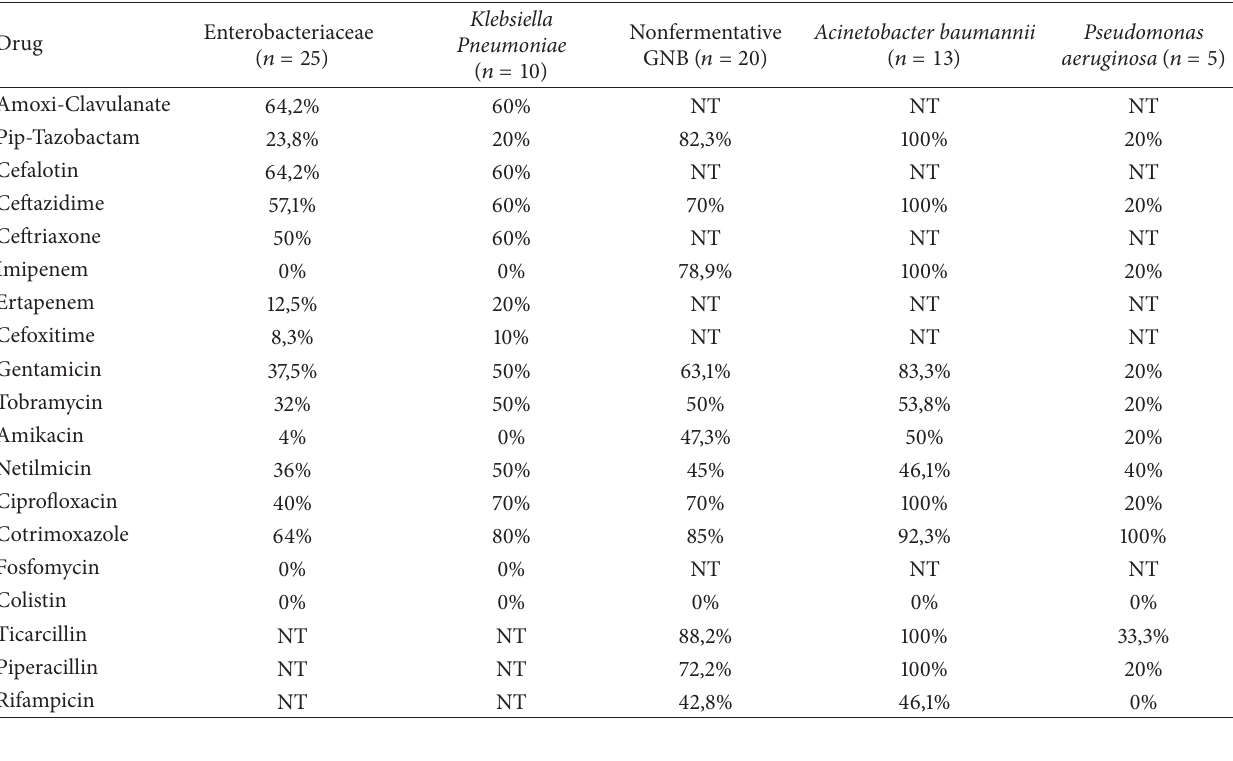
Table 3: Antimicrobial resistance rate of Gram negative bloodstream isolates.